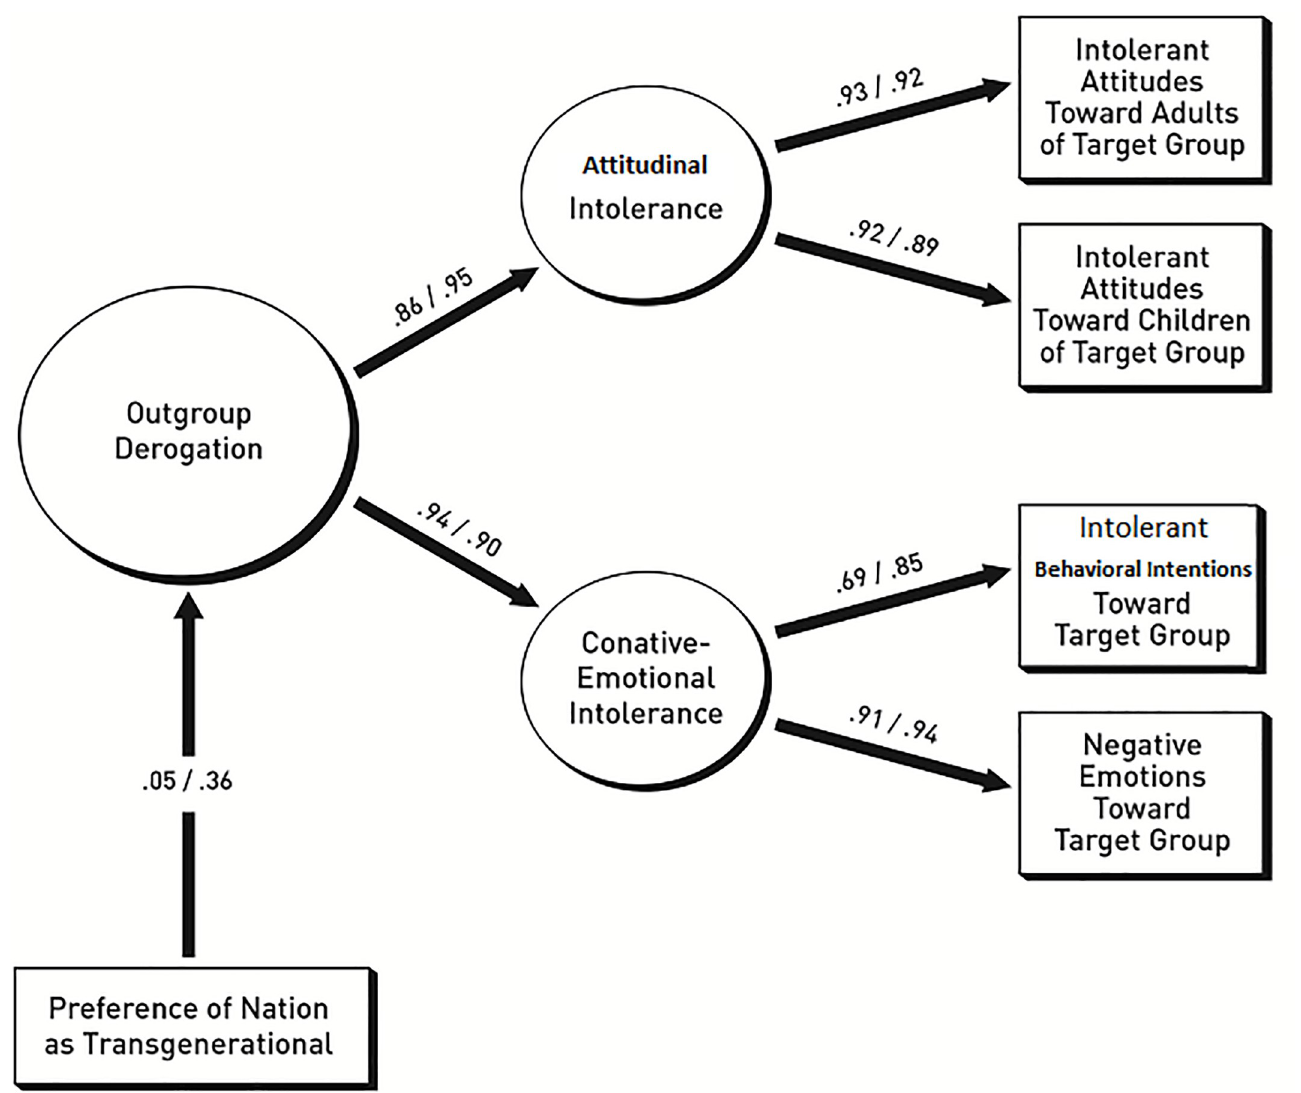
Fig 1. Prediction of derogation of diaspora migrants and of ‘foreign’ migrants by level of TG preferences. Left coefficient: Aussiedler/right coefficient: ‘foreign’ migrants. https://doi.org/10.1371/journal.pone.0230303.g001 Fig 1 documents the results of our SEM analyses, conducted as a two-group comparison. The graphic display of our results omits all error terms as well as the two control variables. Goodness-of-fit for the documented model was excellent: χ 2 = 26.853, df = 23, p = .262, CFI = .993, RMSEA = .030, PCLOSE = .758. As shown in the figures the ß-coefficients from TG onto outgroup derogation differ substantially: For diaspora migrants the path is ß = .05, p = .661; 2 it was ascertained that the two for Turkish migrants the path is ß = .36, p < .001. Using Δ χ coefficients differ significantly: The difference between the χ 2 scores for a freely estimated 2 model and a model restricting the path between TG and outgroup derogation to equality is Δ χ = 4.463, p = .035. Our finding confirms Hypothesis 1, namely that TG of study participants would predict derogation of outgroup members differently depending on whether they are diaspora or ‘foreign’ migrants.